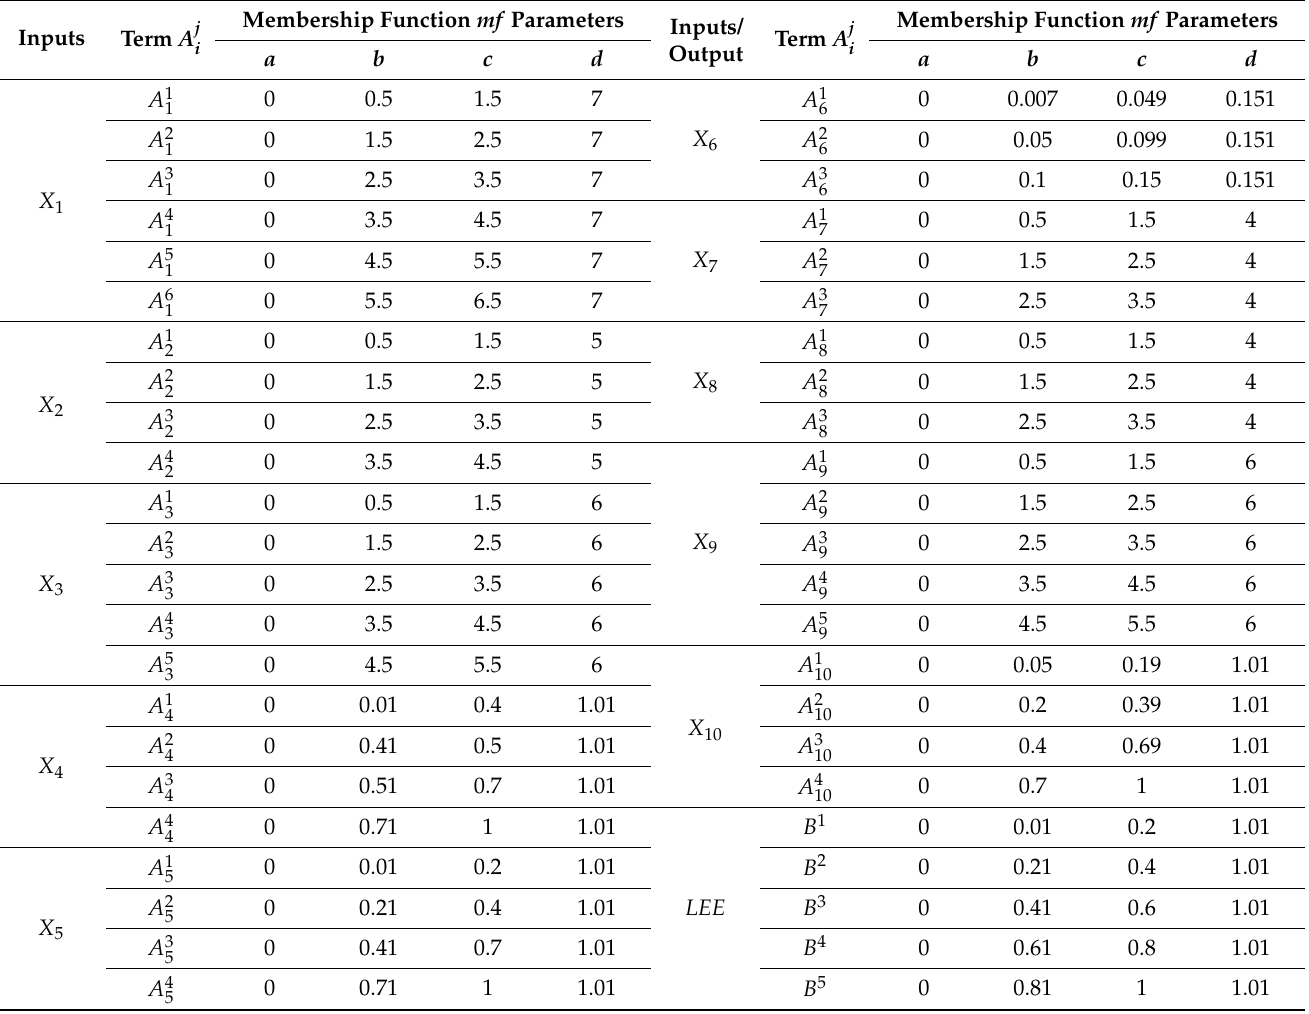
Table 3. Parameters of the membership functions of the system input and output